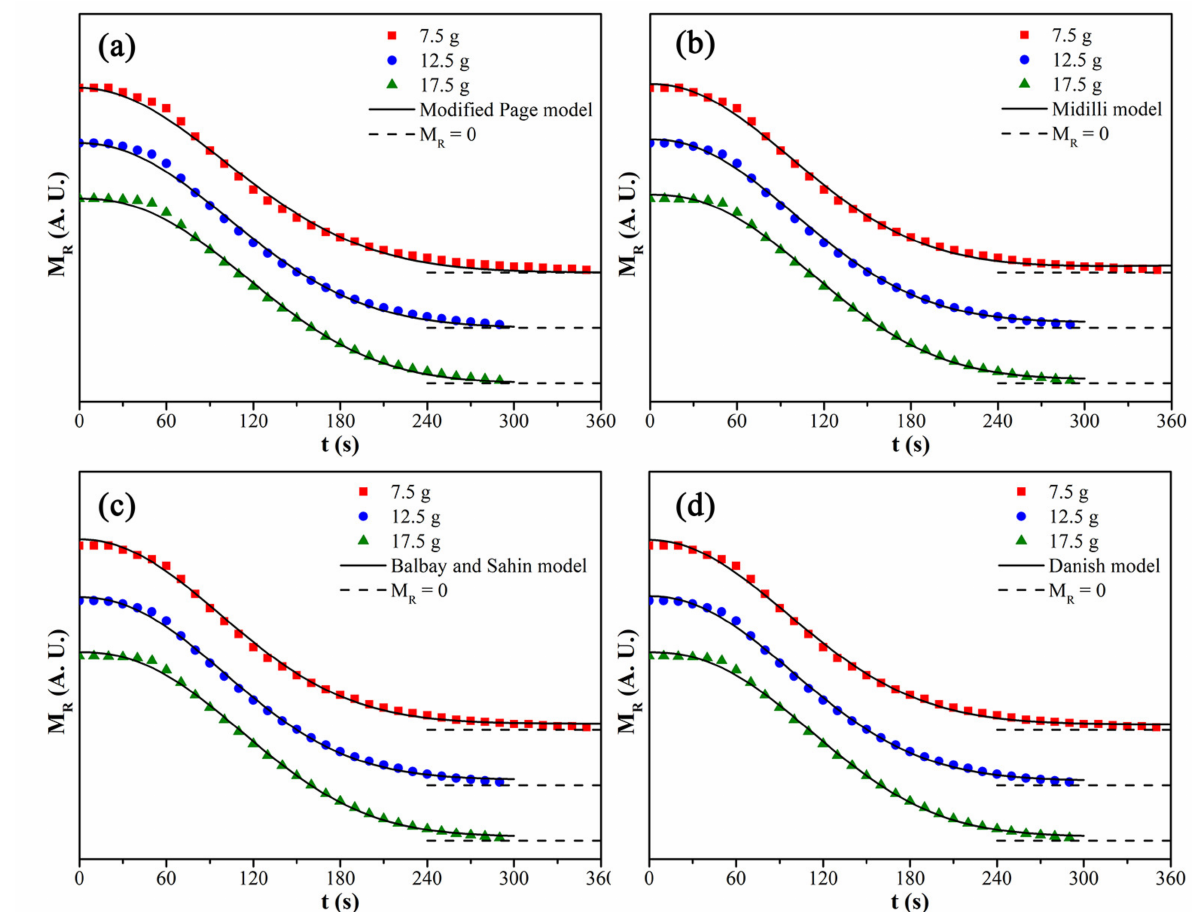
Figure 13. Fitting curves of different kinetic models: ( a ) modified Page model, ( b ) Midilli model, ( c ) Balbay and Sahin model, and ( d ) Danish